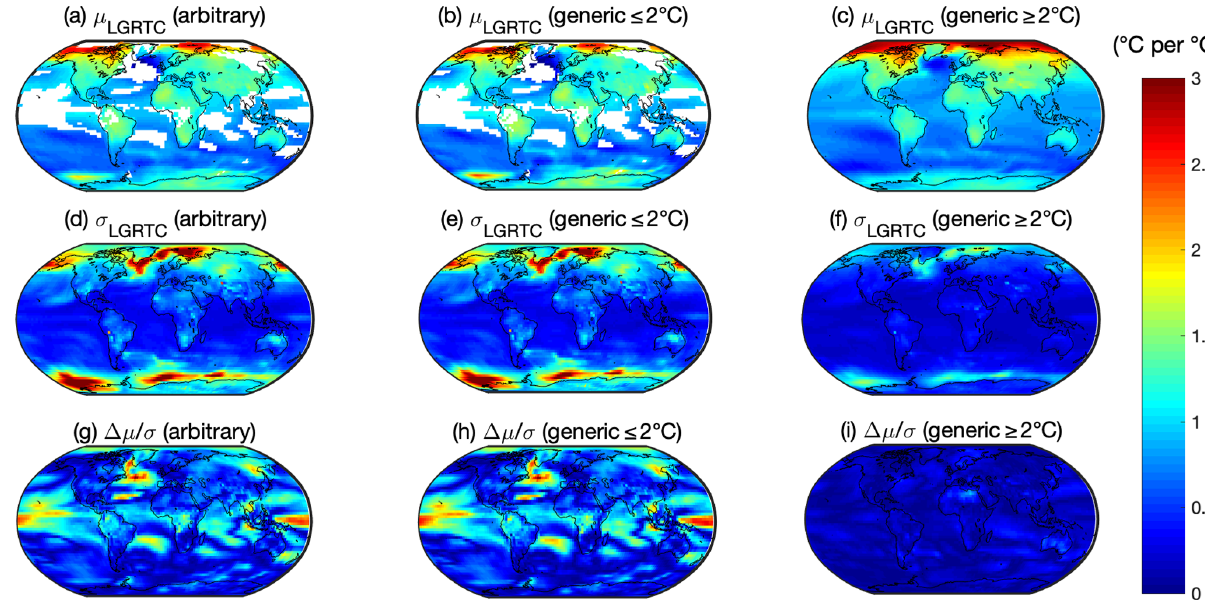
Figure 2. The LGRTC in the arbitrary , generic ≤ 2 ◦ C and generic ≥ 2 ◦ C scenarios. Panels (a–c) show the scenario mean LGRTC. Panels (d–f) show the scenario standard deviation in LGRTC. Panels (g–i) show the ratio of the maximum absolute discrepancy in the mean LGRTC from the underlying RCP scenarios, (cid:49)µ , to the standard deviation in the LGRTC, σ , in the combined scenario: (cid:49)µ/σ